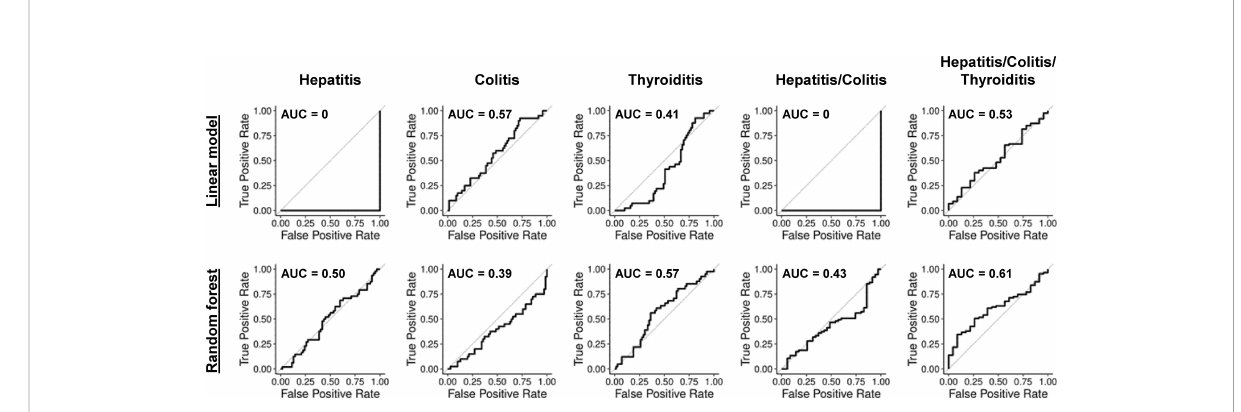
FIGURE 2 ROC-curves for linear models and random forests with previously reported biomarkers and clinical parameters. ROC-curves in LOOCV for penalized logistic regression and random forest models predicting hepatitis (AUC 0 and 0.50), colitis (AUC 0.57 and 0.39), thyroiditis (AUC 0.41 and 0.57), hepatitis and/or colitis (AUC 0 and 0.43) and hepatitis and/or colitis and/or thyroiditis (AUC 0.53 and 0.61).